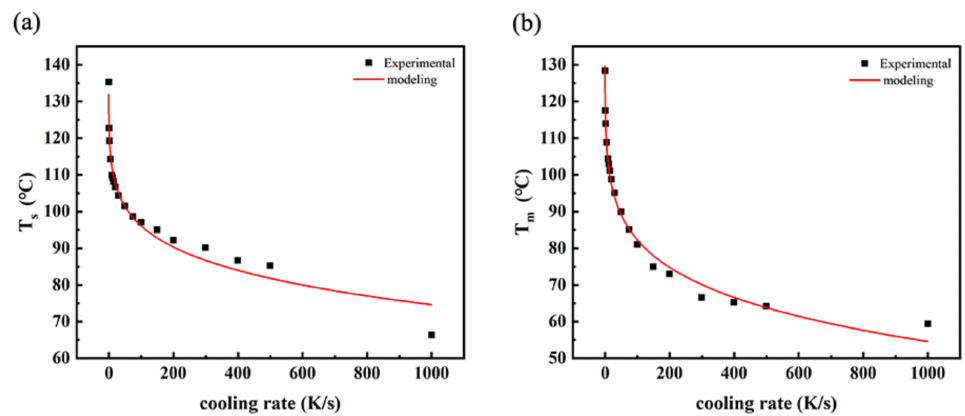
Figure 4. The relationship between the crystallization temperatures (( a ) T s and ( b ) T m ) and cooling rate r of PP.